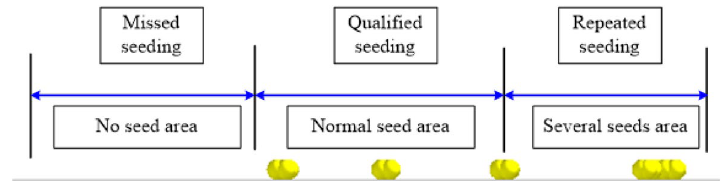
Figure 10. Distribution of corn seeds in the forward direction after simulation.